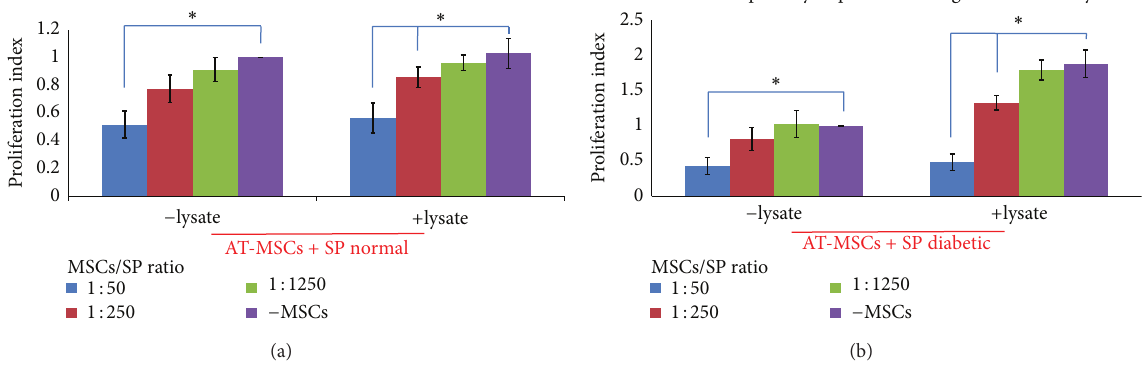
Figure 2: Proliferation index of splenocytes from normal (a) and diabetic (b) mice cocultured with AT-MSCs in presence of islet cells lysate as specific stimulator. Diabetic splenocytes showed a sharp proliferation in the presence of lysate, in which normal splenocytes remained nonproliferated. AT-MSCs caused cell death of some resting splenocytes in the absence of lysate (proliferation index < 1.0). AT-MSCs could suppress diabetic splenocytes proliferation in response to lysate in a dose-dependent manner, where higher concentration of AT-MSCs inducedcelldeathinsomesplenocytes(proliferationindex < 1.0).Eachbarrepresentstheaverageoffiveindependentexperiments. ∗ indicates significant difference between groups ( 𝑃 < 0.05 ). Lysate: pancreatic islet cells lysate; SP: